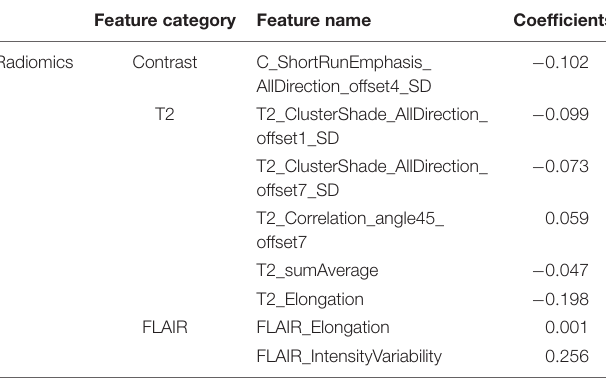
TABLE 3 | Features and their corresponding coefficients in the radiomics